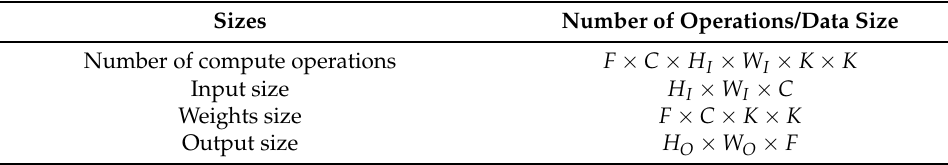
Table 2. Number of operations and the data size for a